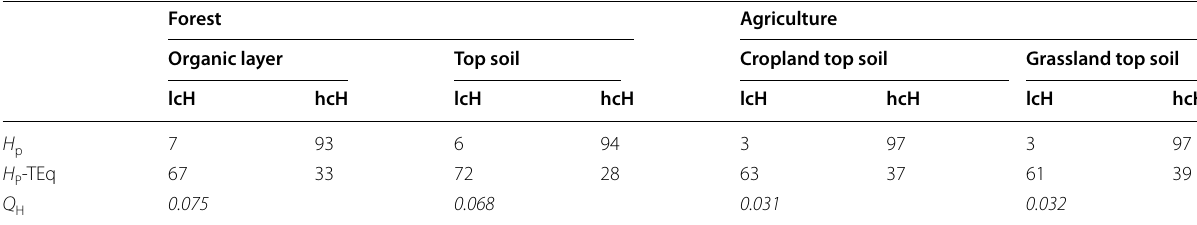
Q H , homologue quotient of lcH to hcH [dimensionless]; H p , homologue pattern of lcH to hcH [%]; H p -TEq, homologue pattern of lcH and hcH in terms of TEq [%]